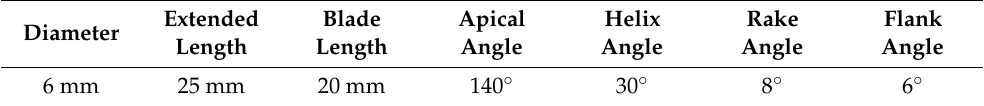
Table 1. Geometric parameters of drill